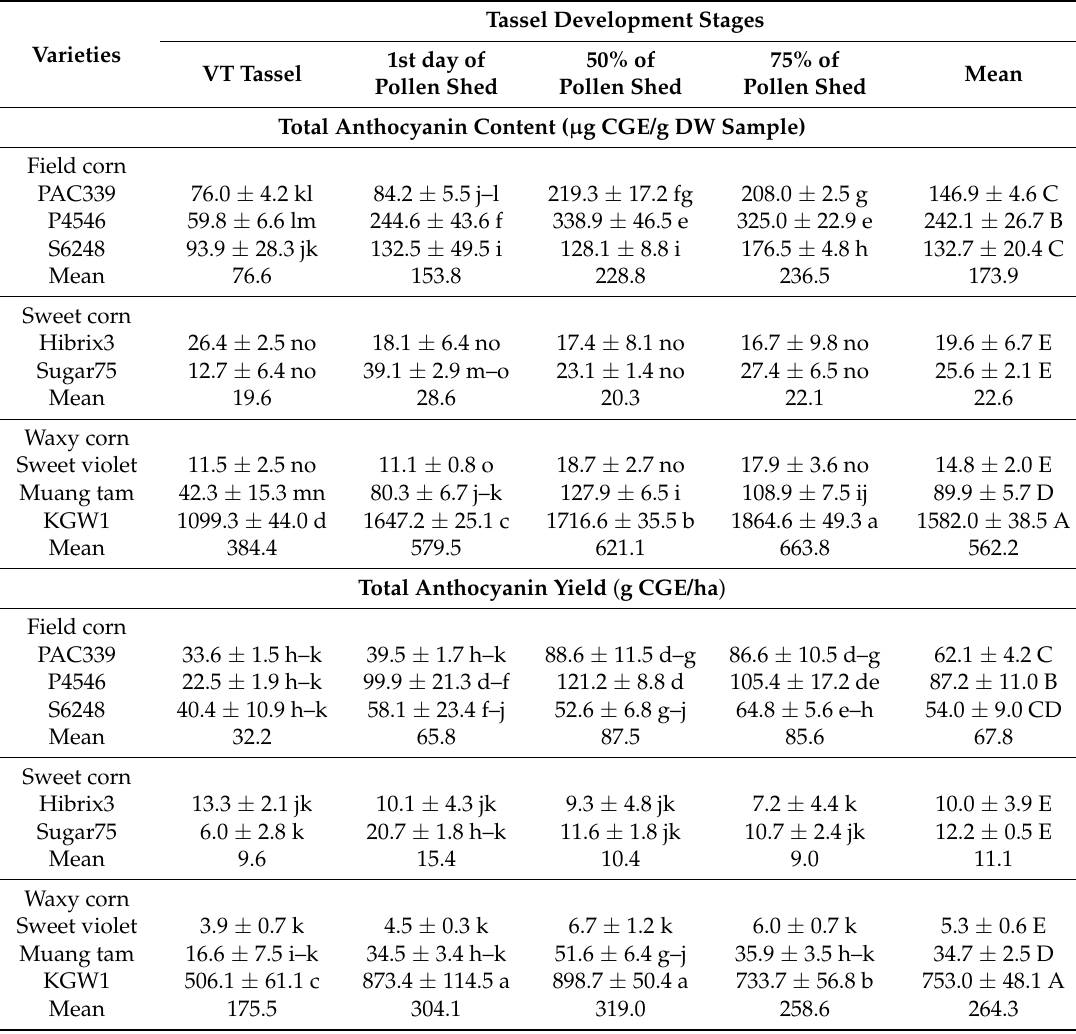
Table 4. Means for total anthocyanin content and total anthocyanin yield in the tassels of eight corn varieties evaluated at four tassel development